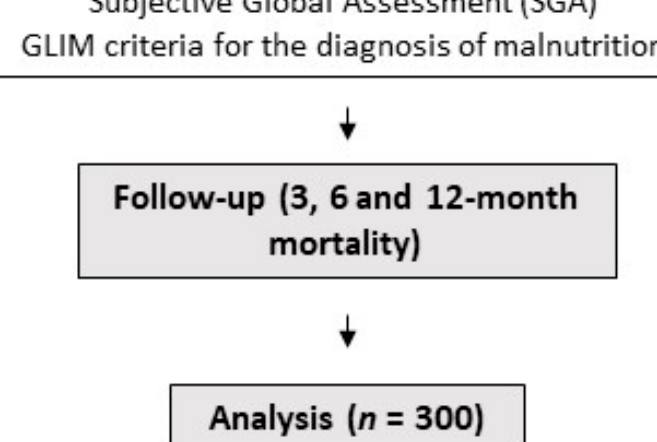
Figure 1. Study flow diagram and research methodology. The general characteristics of the sample are shown in Table 1. The mean triceps skinfold was 11.9 ± 4 mm for men, giving an FFMI by anthropometry of 19.4 ± 8.6 kg/m 2 (25.8% below 17 kg/m 2 ). In women, the mean triceps skinfold was 15.7 ± 6.1 mm, determining an FFMI of 17.4 ± 2.9 kg/m 2 (19.7% below 15 kg/m 2